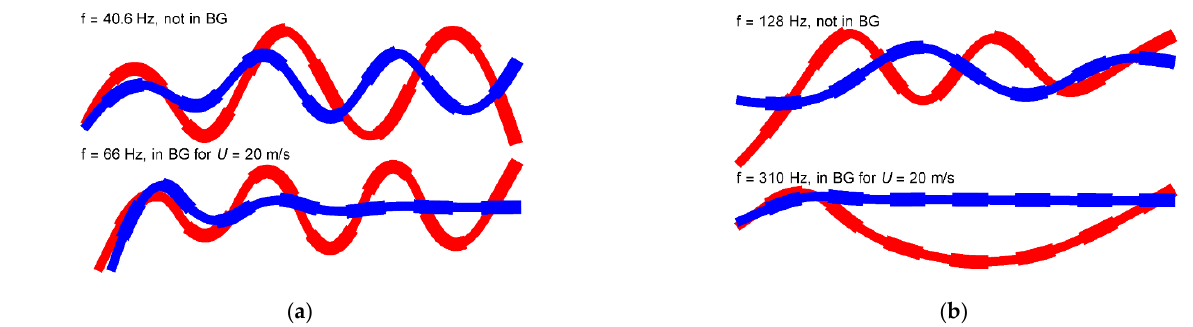
Figure 7. Frequency responses of the fluid-conveying periodic pipe with different numbers of cells.